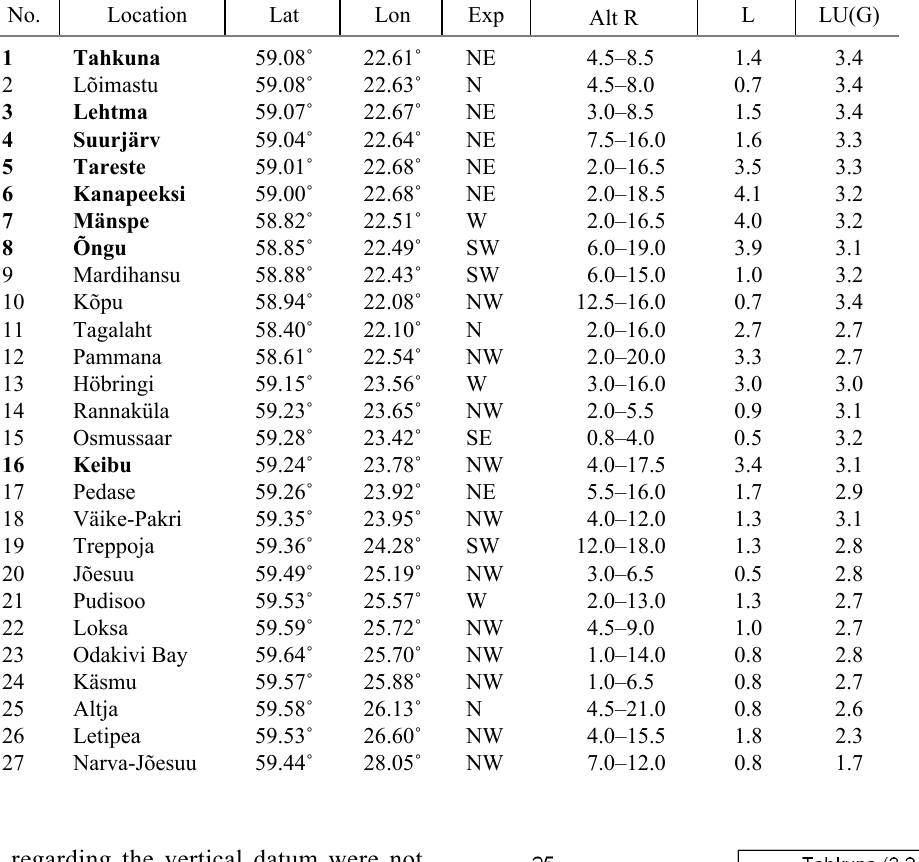
Table 1. Overview of cross sections through some of the rhythmic beach ridge systems in Estonia (Fig. 1). Lat, latitude (N); Lon, longitude (E); Exp, shore exposition direction; Alt R, altitude range (m a.s.l.); L, total profile length (km); LU(G), land uplift rate relative to geoid (mm/yr) (Suursaar & Kall 2017). The locations for detailed description (Table 2) are shown in bold